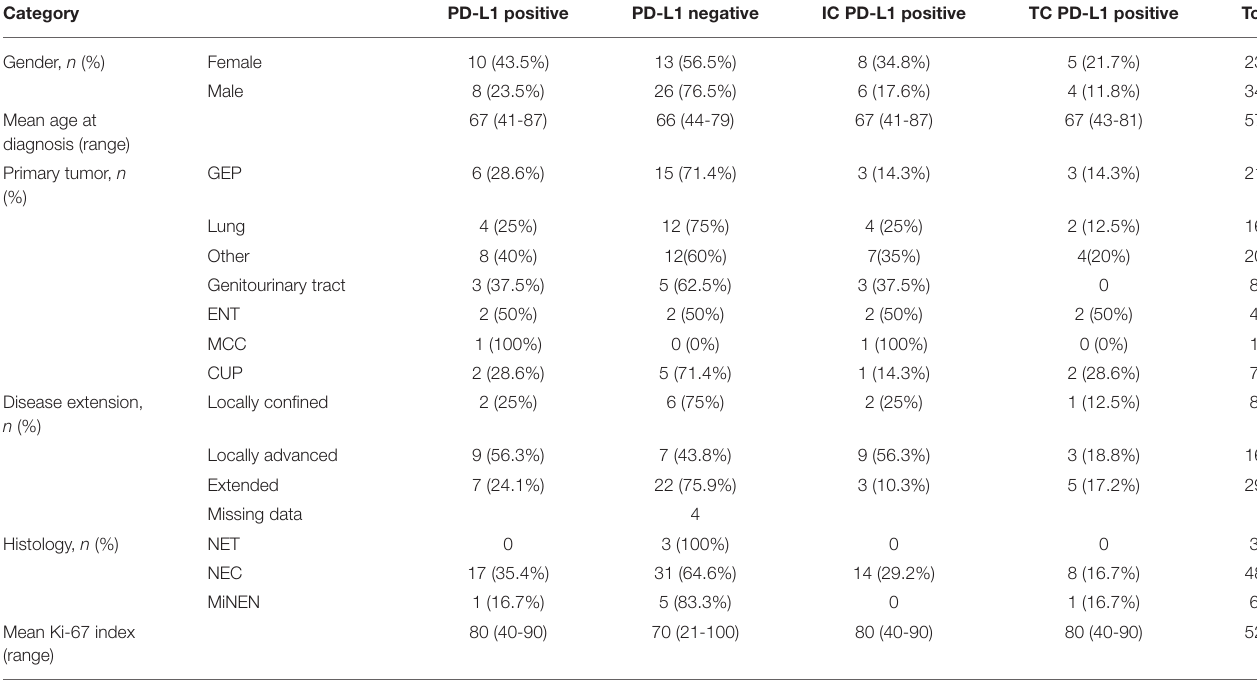
TABLE 1 | Clinicopathological data and PD-L1 expression overall; PD-L1 positive cases on tumor cells and on immune cells. Category PD-L1 positive PD-L1 negative Gender, n